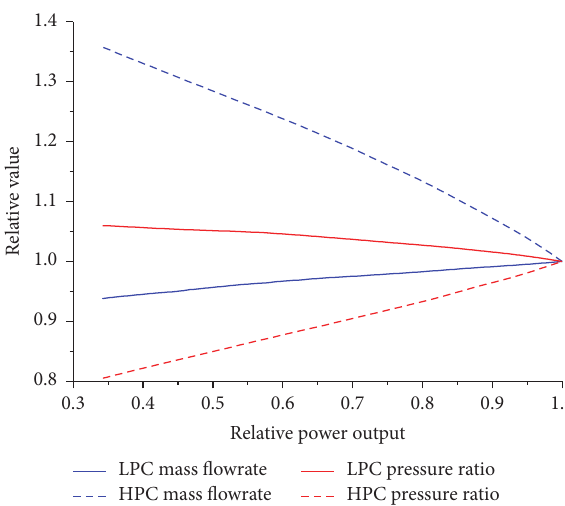
Figure3:Pressureratioandflowratecharacteristicswhenbypassing